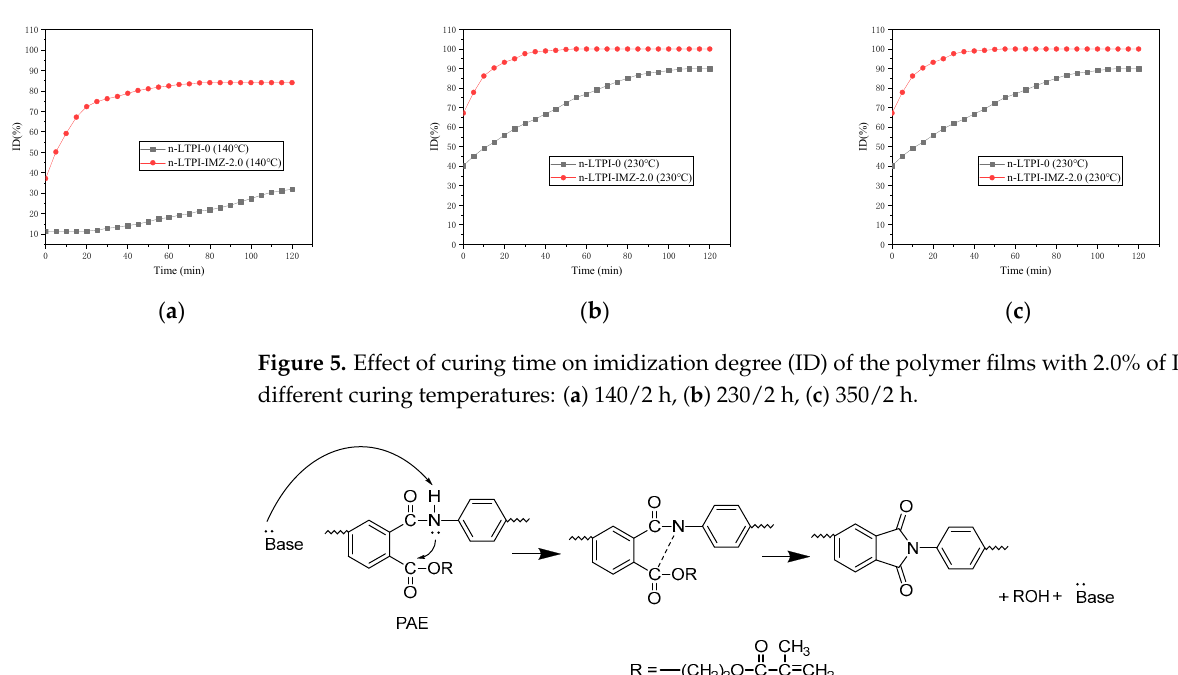
Figure 4. Effect of curing temperature on imidization degree (ID) of the thermally cured films with different heteroaromatic bases.